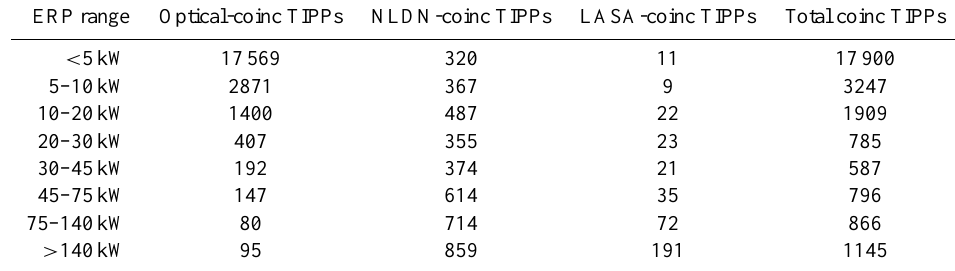
Table 3. Number of TIPPs with given low-band (26–49MHz) ERP and coincidence source (Optical, NLDN, and LASA). Total=27235 (unique: 21874).